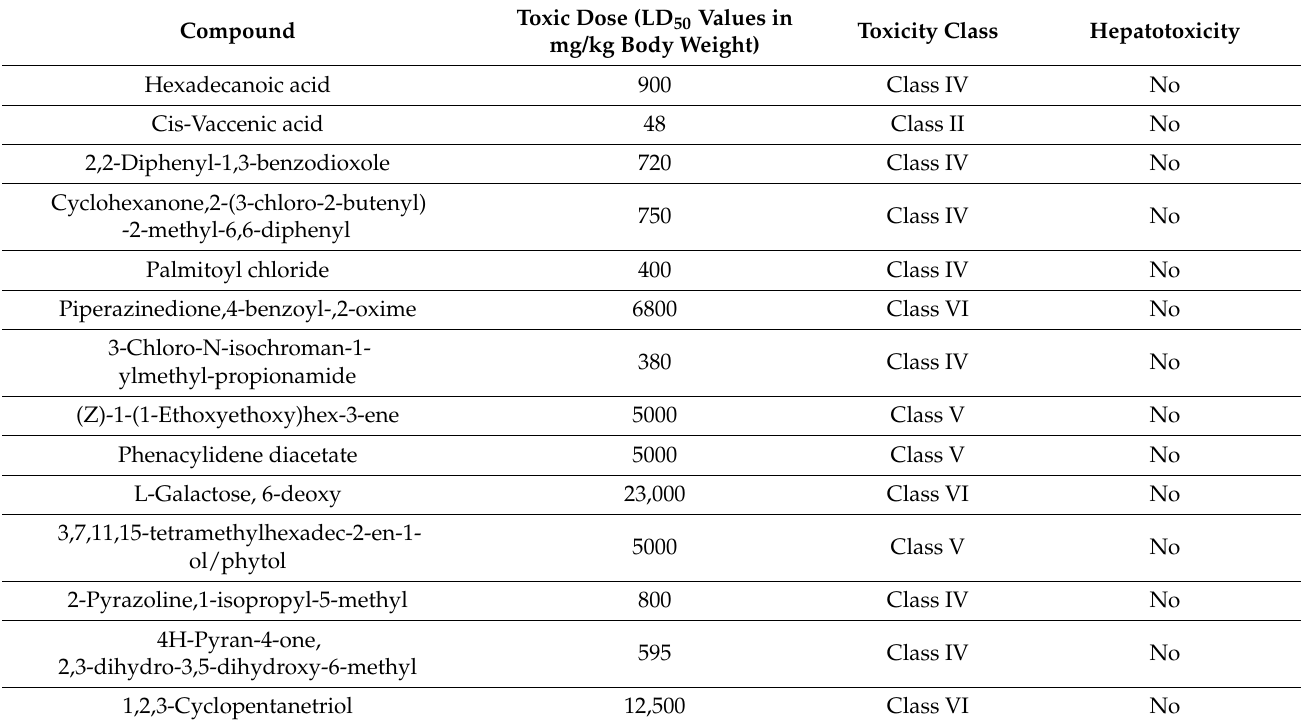
Table 6. Toxicity